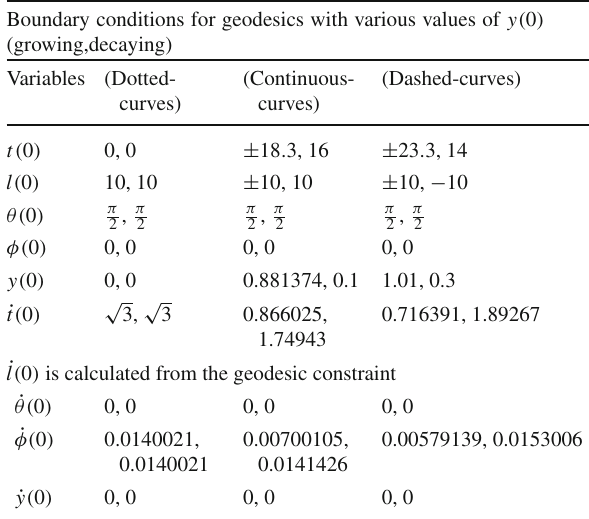
Table 3 Boundary values used for Fig. 11 Boundary conditions for geodesics with various values of y ( 0 ) (growing,decaying) Variables (Dotted- (Continuous- curves) curves)